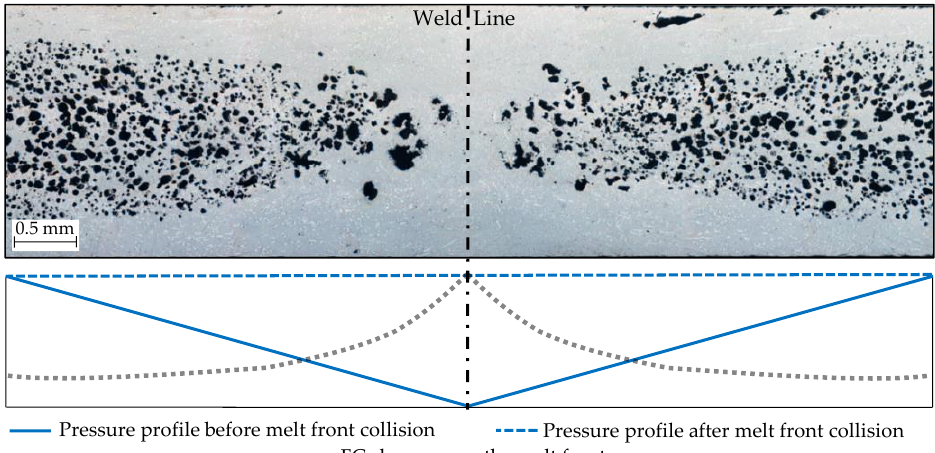
Figure 6. Microscopic image of the weld line at sampling location 1. Schematic of pressure as a function of sample width is demonstrated for before and after melt front collision.